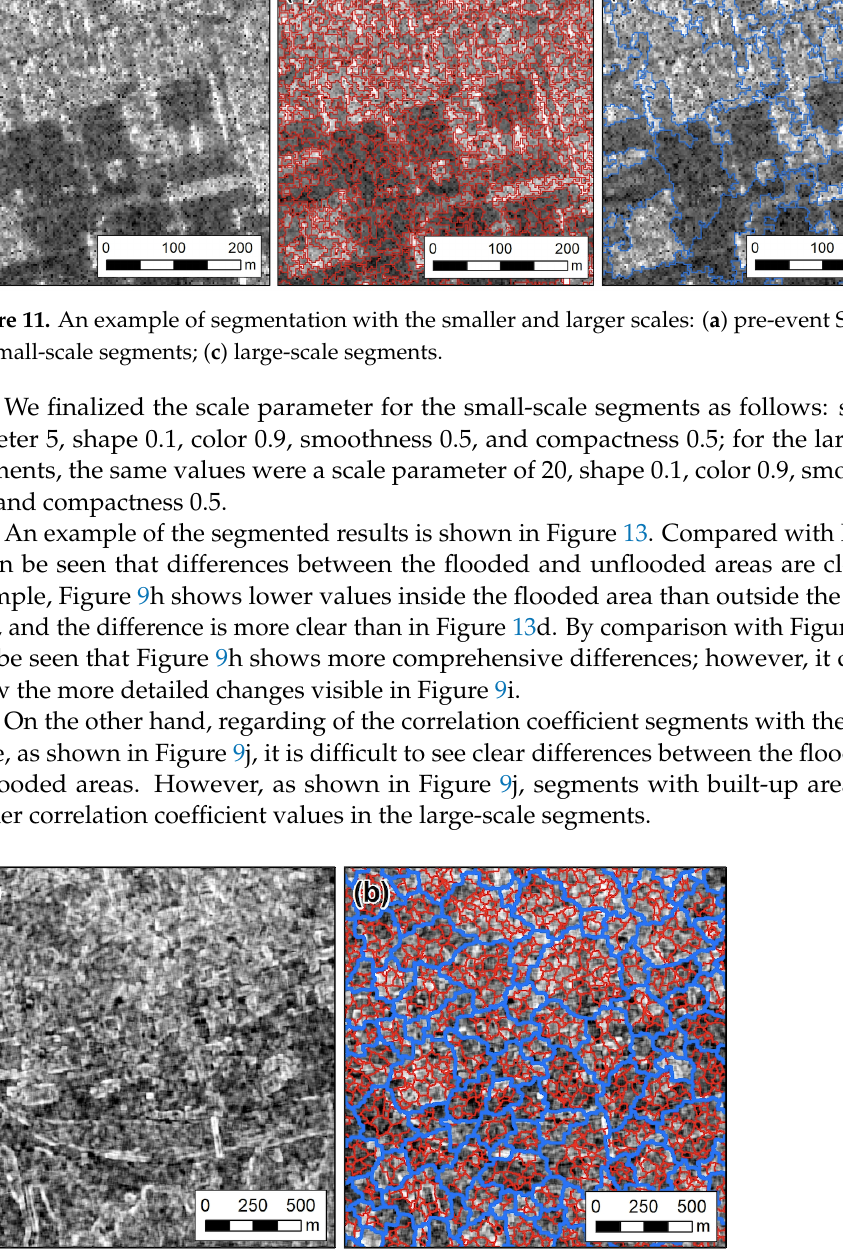
Figure 12. An example of segmentation in a correlation coefficient image: ( a ) correlation coefficient image and ( b ) segments with smaller and larger